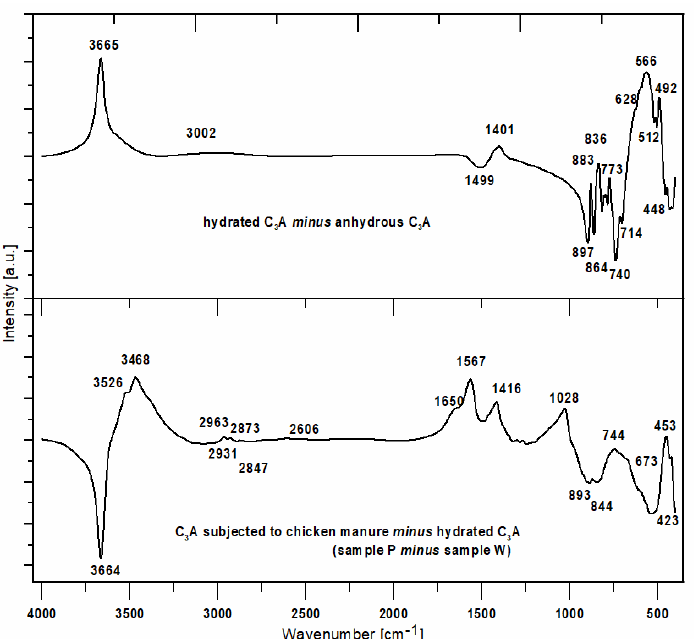
Figure 18. Differential spectra between the hydrated and dry C 3 A phase (hydrated C 3 A minus anhydrous C 3 A) — upper panel, or between hydrated C 3 A and C 3 A treated with chicken manure (sample P minus sample W) — lower panel. Characteristic wavenumbers, as indicated, respectively.